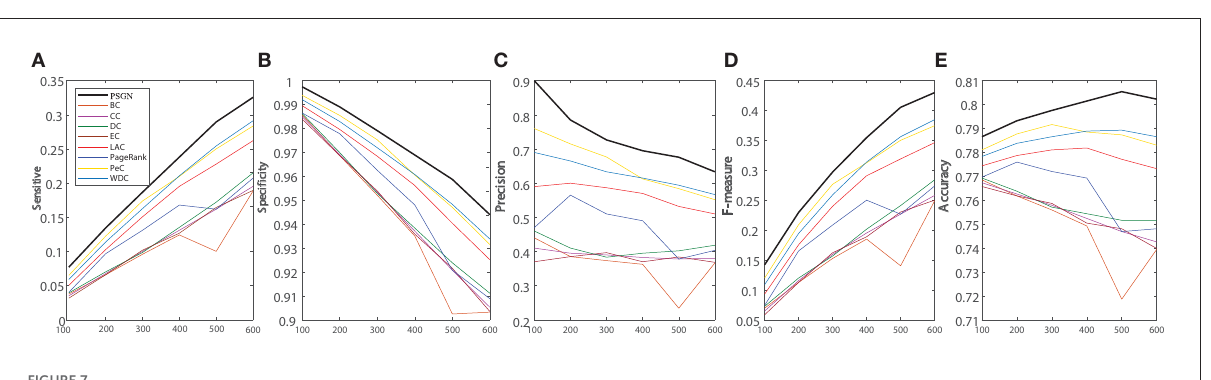
FIGURE7 Comparative experiments on the Yeast PPI networks in terms of sensitive (A) , specificity (B) , precision (C) , F-measure (D) , and accuracy (E) obtained by PSGN, BC, CC, DC, EC, LAC, PageRank, PeC, and WDC.